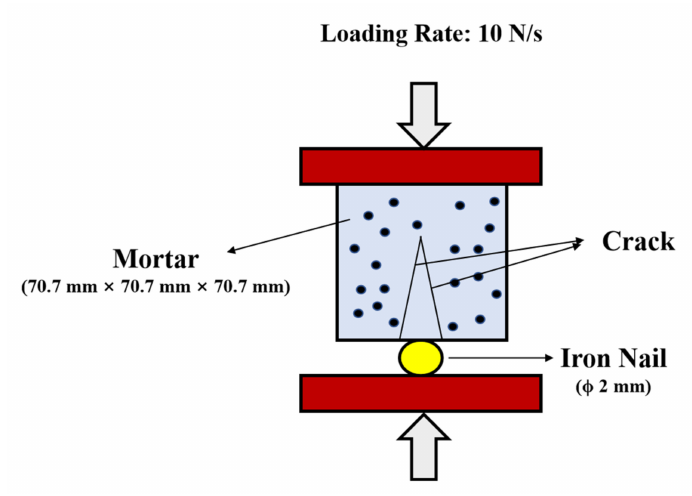
Figure 2. Schematic diagram of the test for mortar